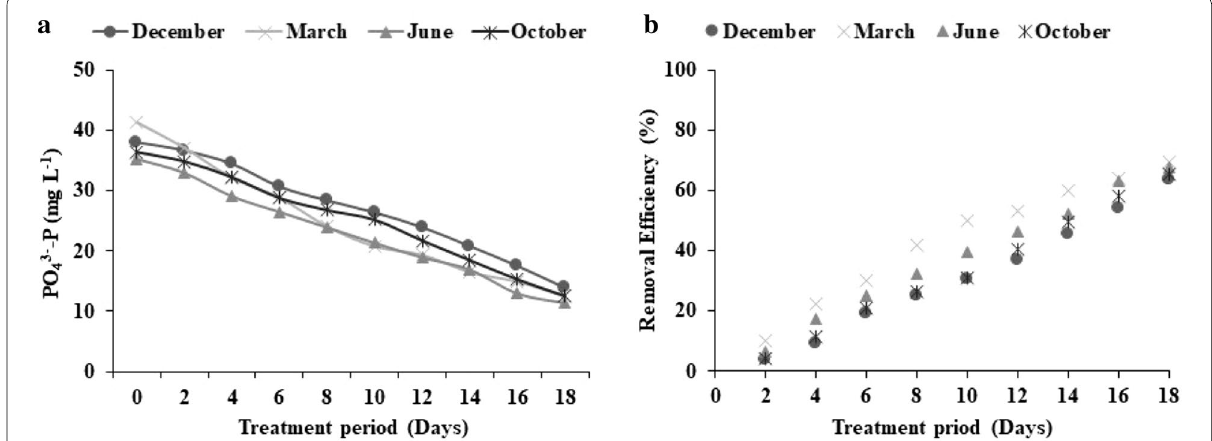
Fig. 4 Change of concentration ( a ) removal efficiencies ( b ) of PO 43 − - P over the experimental periods of each season